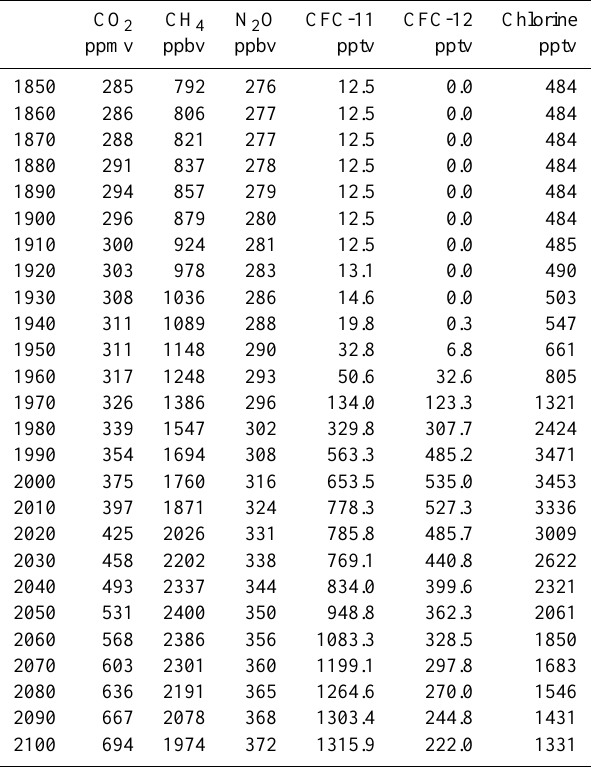
Table 4. Time series of mixing ratios of GHGs and total inorganic chlorine as used in the reference